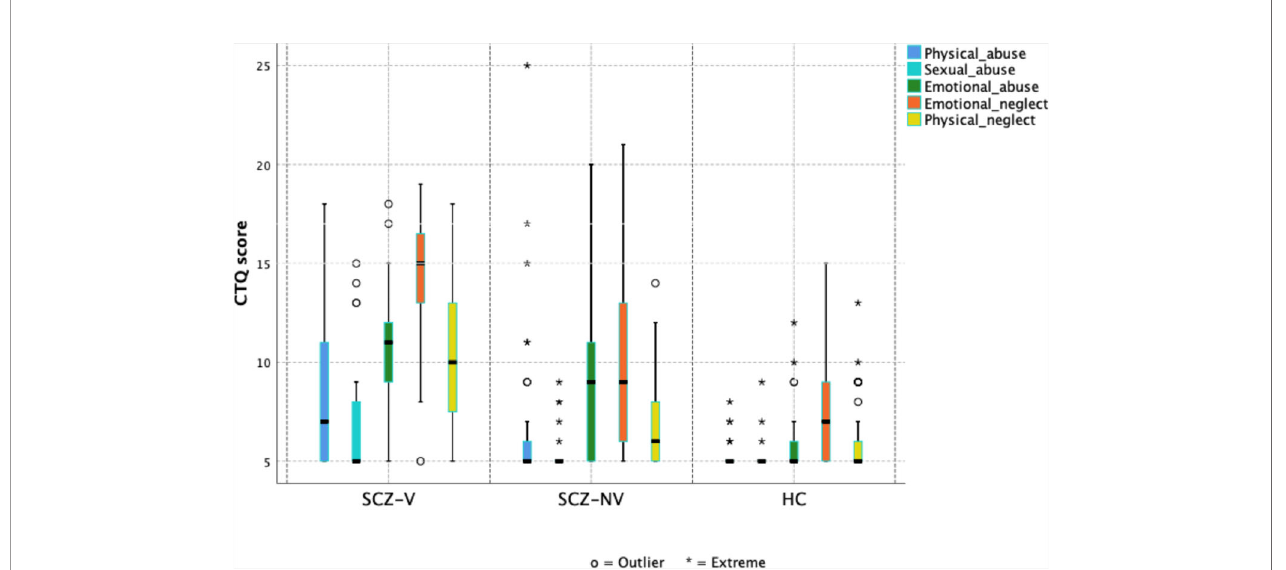
FIGURE 1 | Box plots showing the distribution of childhood trauma (CTQ scores) in total and across subdomains, strati fi ed by diagnostic group. SCZ-V, Schizophrenia with a history of violence (n = 19); SCZ-NV, Schizophrenia without a history of violence (n = 34), HC, Healthy controls (n =